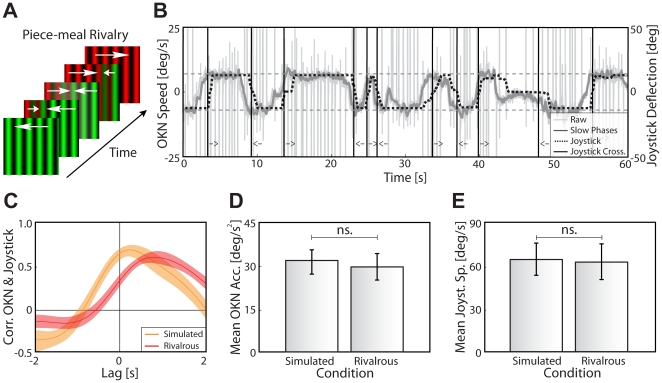
Experiment 4–Piece-mealing and joystick report.(A) Example of piece-meal rivalry. Piece-meal rivalry consists of gradual transitions between percepts during which parts of both percepts are spatially intermixed. (B) OKN speed (notation as in Figure 2B) compared to joystick deflection (dashed black line) for a single rivalrous trial of a single observer. Joystick deflection was a good indicator of rivalry dynamics and delineated intermediate states. (C) Cross-correlation of OKN speed and joystick deflection (positive lags: OKN leading), mean and s.e.m over dominance durations; red: real rivalry, orange: simulated rivalry (piece-meal). Observers had longer latencies and lower peak correlations for rivalrous trials as compared to simulated rivalry trials. (D) OKN acceleration in a 0.2s time window around OKN zero-crossings, mean and s.e.m. across observers for simulated (left) and real rivalry (right). Unlike for the abrupt changes in experiment 2, OKN acceleration was not different from real rivalry trials for piece-meal simulation. (E) Joystick speed in a 0.2s time window around zero crossings of joystick position, mean and s.e.m. across observers for simulated (left) and real (right) rivalry. Speed of the joystick during a perceptual transition did not differ across conditions.